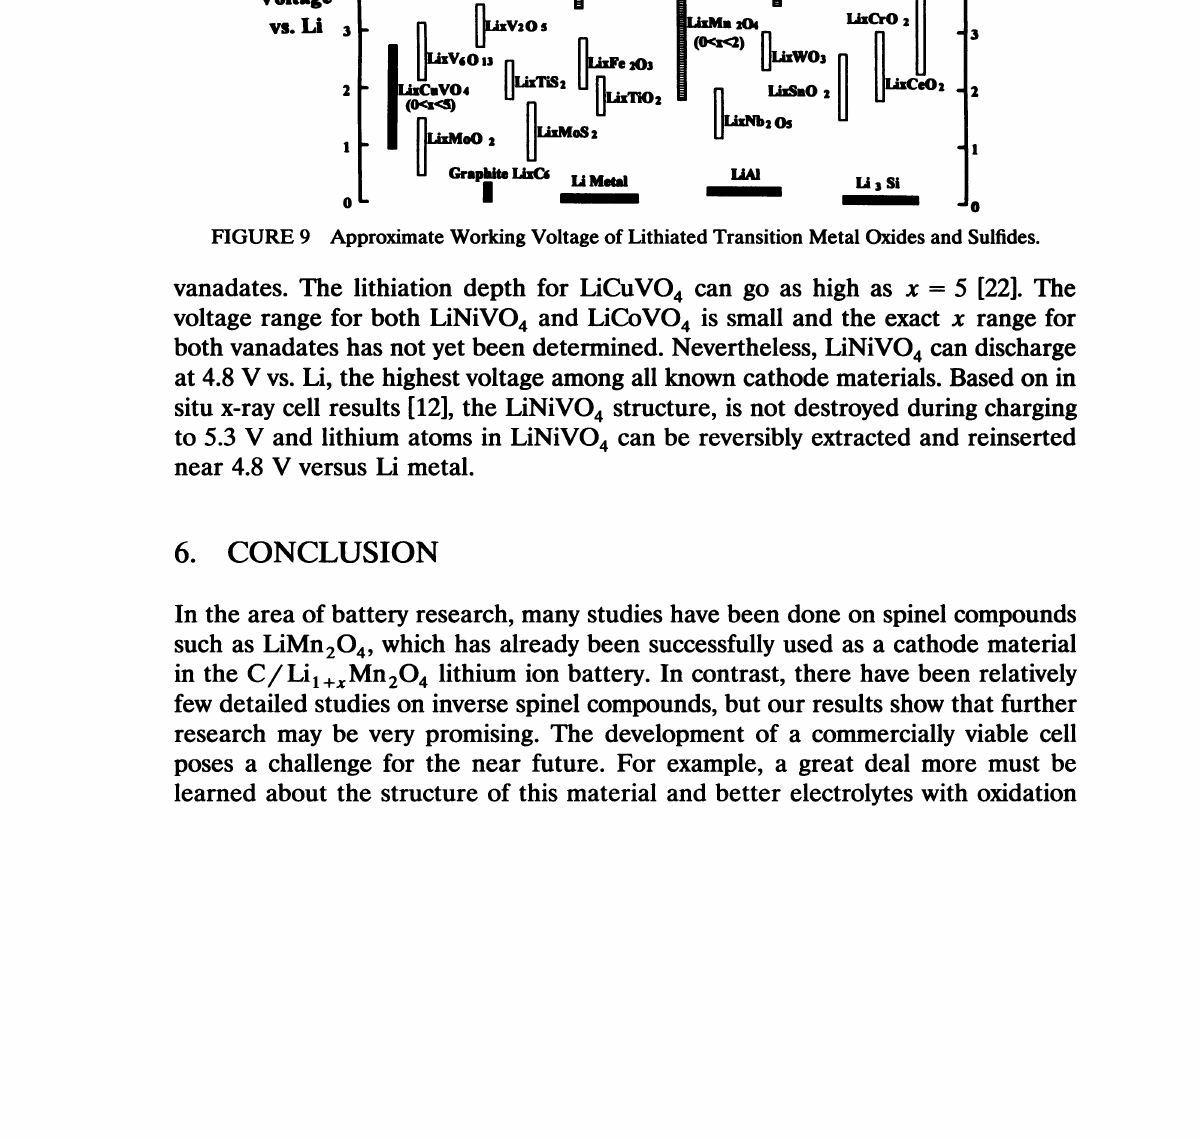
FIGURE 8 Voltage versus Time for a Li/LiCoVO